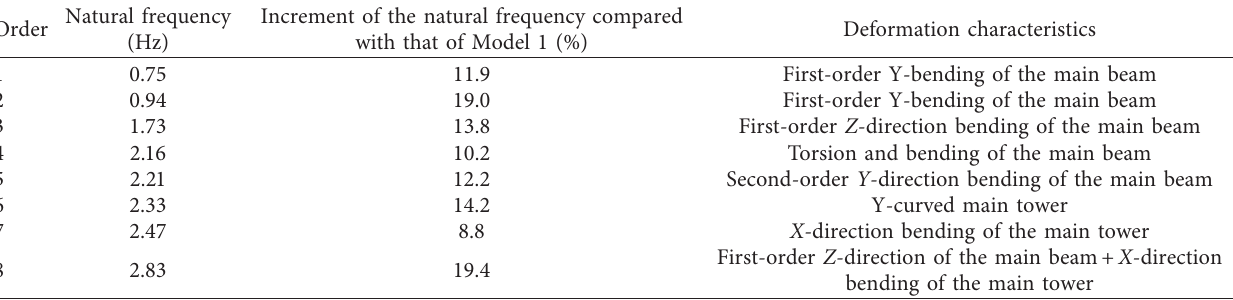
Table 2: Natural frequency and deformation characteristics of Model 2.